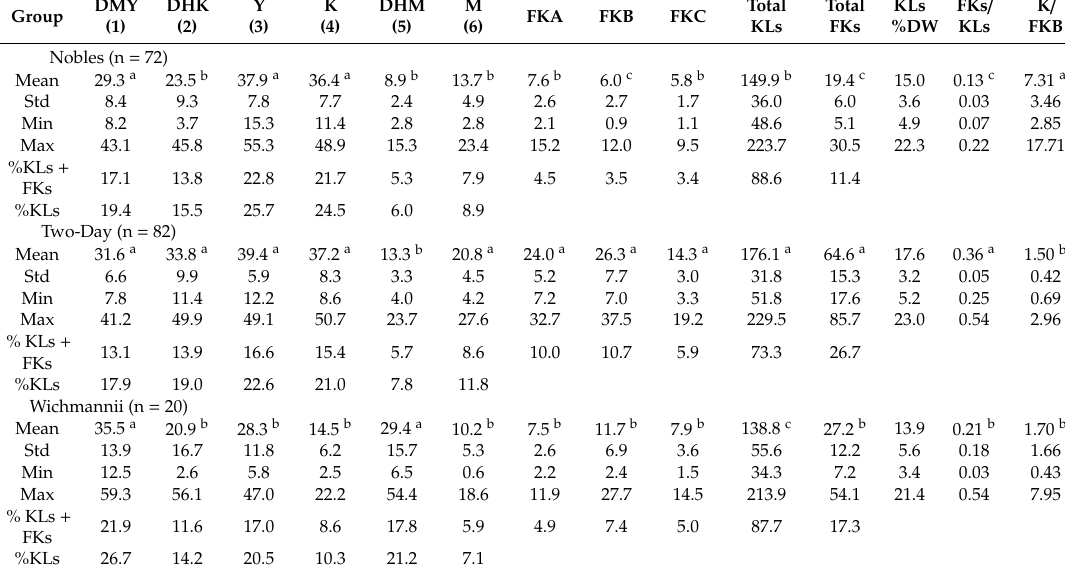
Max 41.2 49.9 49.1 50.7 23.7 27.6 32.7 37.5 19.2 229.5 % KLs + FKs 13.1 13.9 16.6 15.4